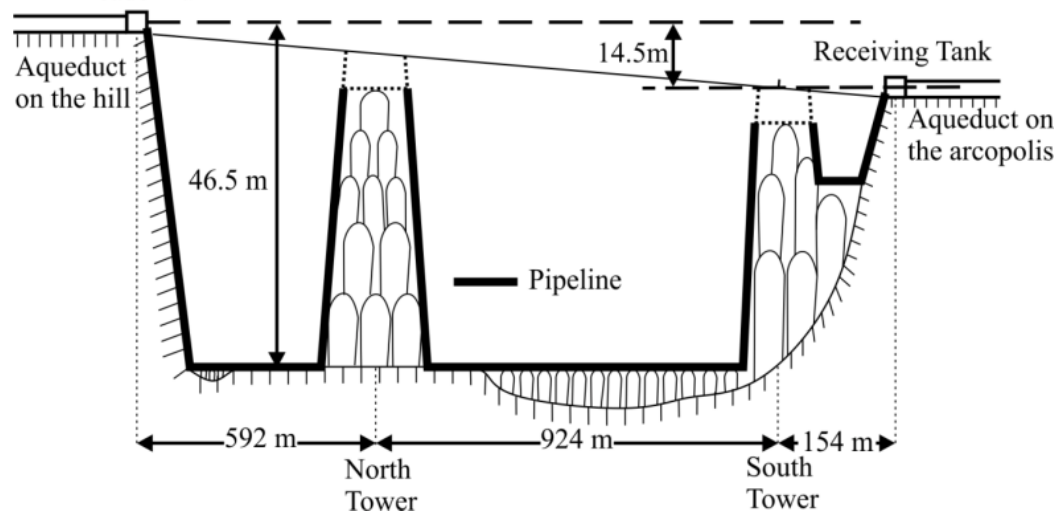
Figure 12. Schematic representation of the triple inverted siphon system in the Aspendos aqueduct (lateral view). Drawings inspired by Kessener and Piras